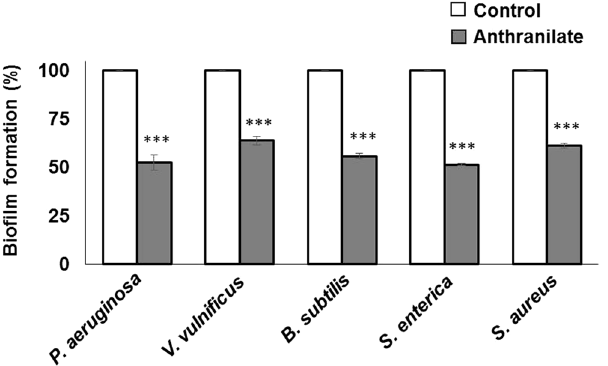
Figure 1. Inhibition of biofilm formation by anthranilate Static biofilm analysis was carried out with various bacteria. Biofilms were formed for 12–16 hours in a static biofilm system in the presence of 0.1 mM anthranilate. Since anthranilate was added to media from 1 M stock made up in dimethyl sulfoxide (DMSO), the same amount of DMSO was added to controls. Biofilm amounts were quantified by crystal violet staining as described in Materials and Methods and are presented as percentages of controls. *** p <